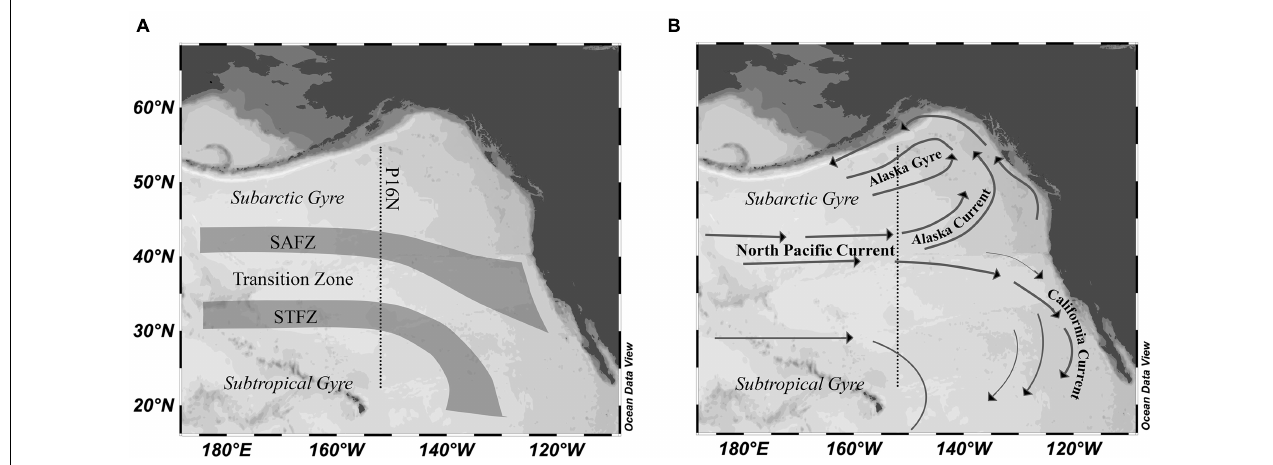
FIGURE 1 | Schematic of the transitional zone within the North Pacific (A) , adapted from Roden (1991) and Lynn (1986), with distributions based on observations of salinity from P16N (May/June 2015) and Global Ocean Data Analysis (GLODAP v2; Olsen et al., 2020). Acronyms are SAFZ (Subarctic Frontal Zone) and STFZ (Subtropical Frontal Zone). Surface circulation of the NE Pacific gyres, adapted from Timothy et al. (2013) (B) . Black dots indicate station locations along section P16N from the Global Ocean Ship-Based Hydrographic Investigations Program (GO-SHIP). This figure and others were created using Ocean Data View (Schlitzer, 2020). The representation is a simplified view of the frontal zones, as frontal structure is complex and meanders are ubiquitous.